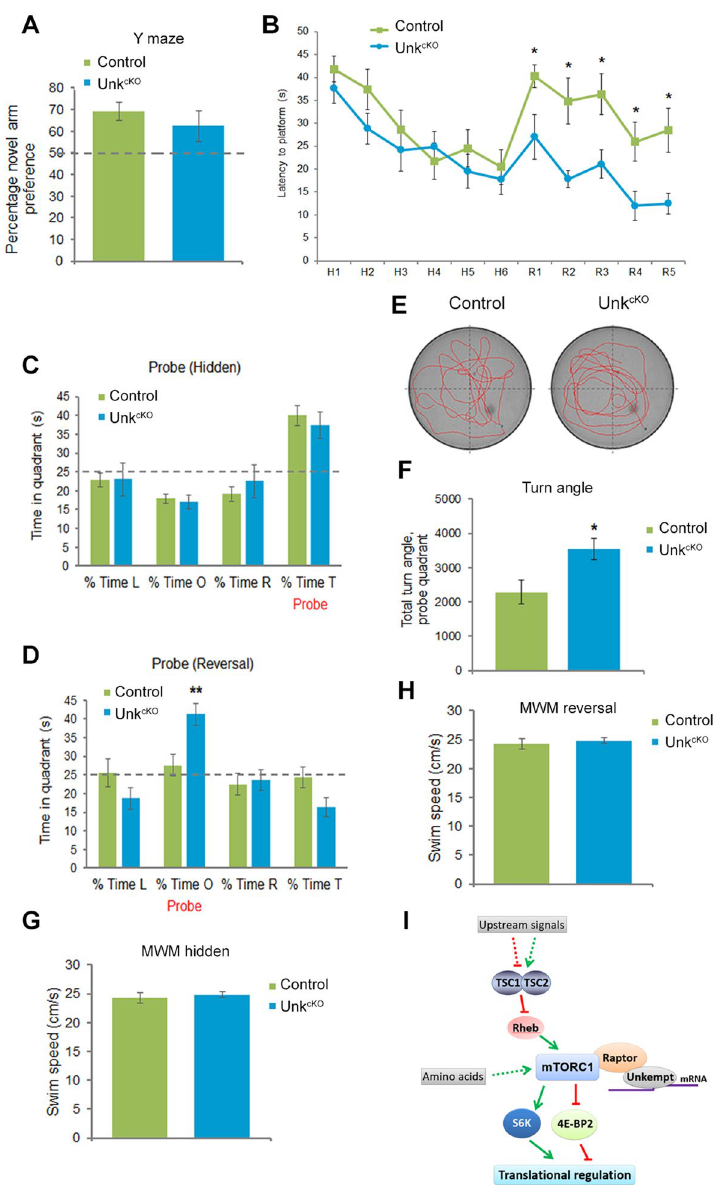
Figure 6. Loss of Unkempt improves reversal learning . ( A ) Y maze, preference for novel arm. ( B ) Unk cKO mice show enhanced cognitive flexibility. The Morris water maze test was carried out by measuring the latency to find the hidden platform for six hidden sessions (H1-6) and then the location of the platform was changed to measure re-learning for another five reversal sessions (R1-5). All mice showed significant spatial learning across the hidden task (session factor F(5, 85) = 10.0, p < 0.0001), but there was no genotype effect (genotype factor F(1, 17) = 1.2, p = 0.3). In the reversal task, all mice showed significant reversal learning (session factor F(4, 68) = 6.7, p < 0.01) but there was a significant genotype effect (genotype factor F(1, 17) = 14.3, p = 0.001) with Unk cKO mice displaying much greater cognitive flexibility than control mice. ( C , D ) Probe trial data showing the percentage of time spent in each quadrant after the hidden ( C ) and reversal ( D ) trials. L = left, O = opposite, R = right, T = target quadrant. Unk cKO mice showed a significant preference for the opposite quadrant, indicating reference memory in the reversal task (t(17) = − 3.3, p < 0.01). ( E ) Representative tracing of control and Unk cKO mice in the probe trial of the Morris water maze reversal task. The platform is located in the bottom right quadrant. ( F ) Turn angle (degrees) made by mice during the probe trial for the reversal task was significantly increased in Unk cKO compared to controls (t(17) = 2.6, p < 0.05). ( G , H ) Swim speed during hidden ( G ) and reversal ( H ) Morris water maze (MWM) probe trials. Control n = 11, Unk cKO n = 8. Statistical significance for genotype effects for each session (genotype factor) and between the daily sessions (session factor) of the Morris water maze were calculated using two-way ANOVA. Comparisons between Unk cKO and control mice were made using a Students t-test, * p < 0.05, ** p < 0.01 compared to control. ( I ) A model for mTORC1 signaling in the